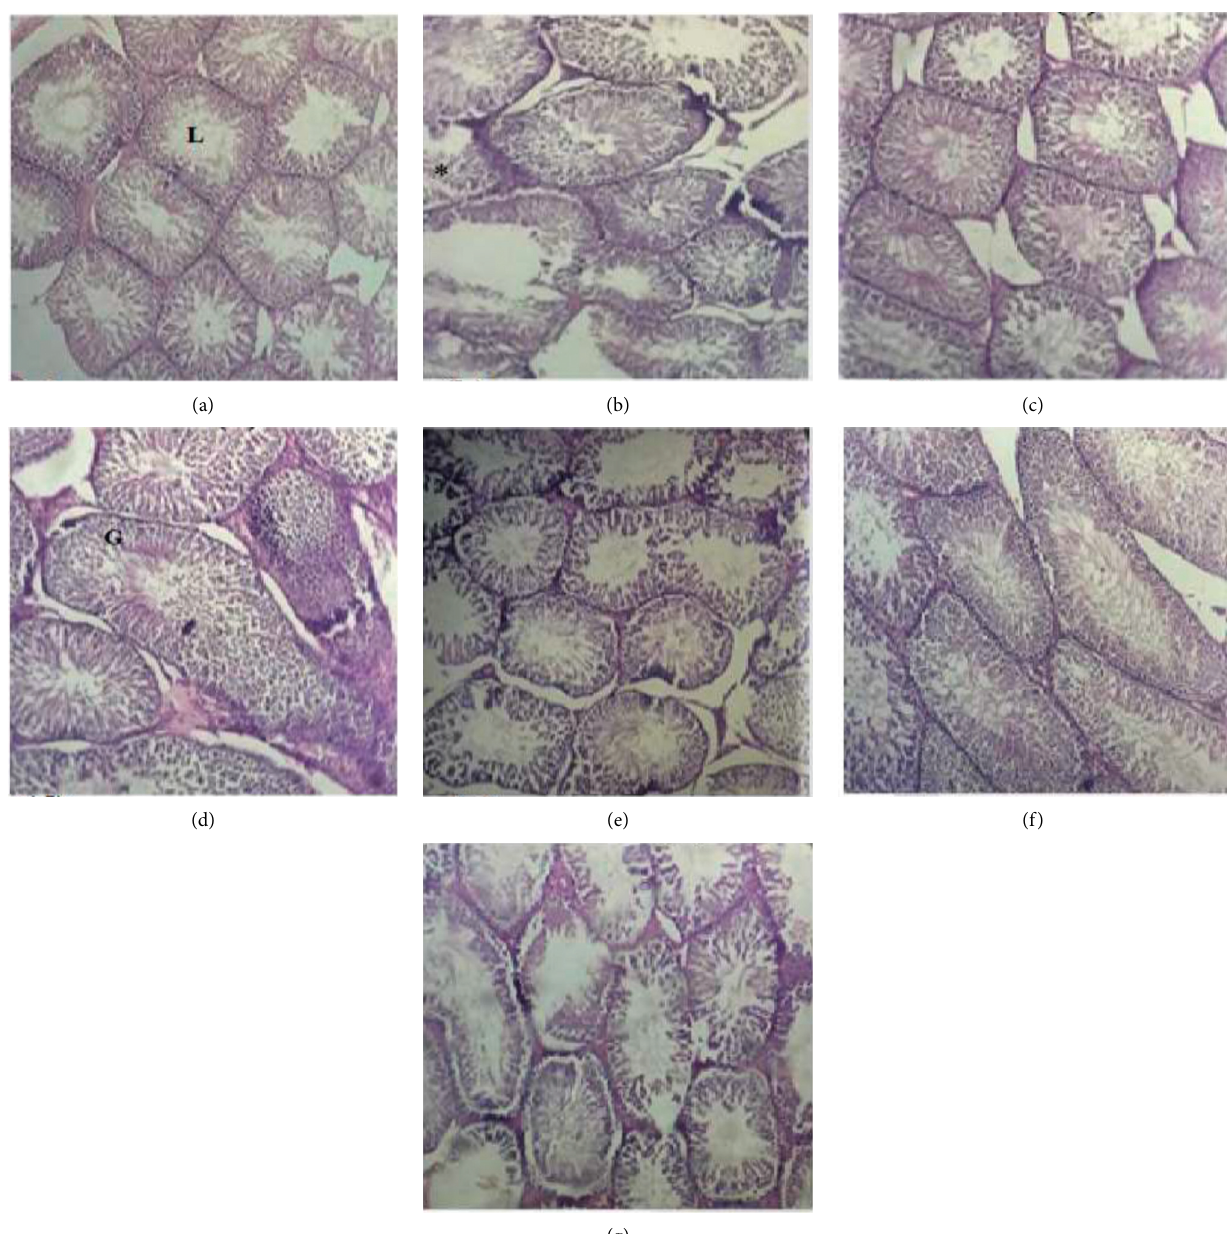
Figure 6: Histological photomicrographs of cadmium-exposed rat testes treated with zinc chloride, lycopene, coenzyme Q10, and L-carnitine. (a) Normal control group. (b) Disease control group. (c) Zinc chloride. (d) Coenzyme Q10. (e) Lycopene. (f) L-Carnitine. (g) Coenzyme Q10 and L-carnitine treated group, whereas “L” showed seminal tubule, “G” germinal epithelium, and ∗ shows vacuole